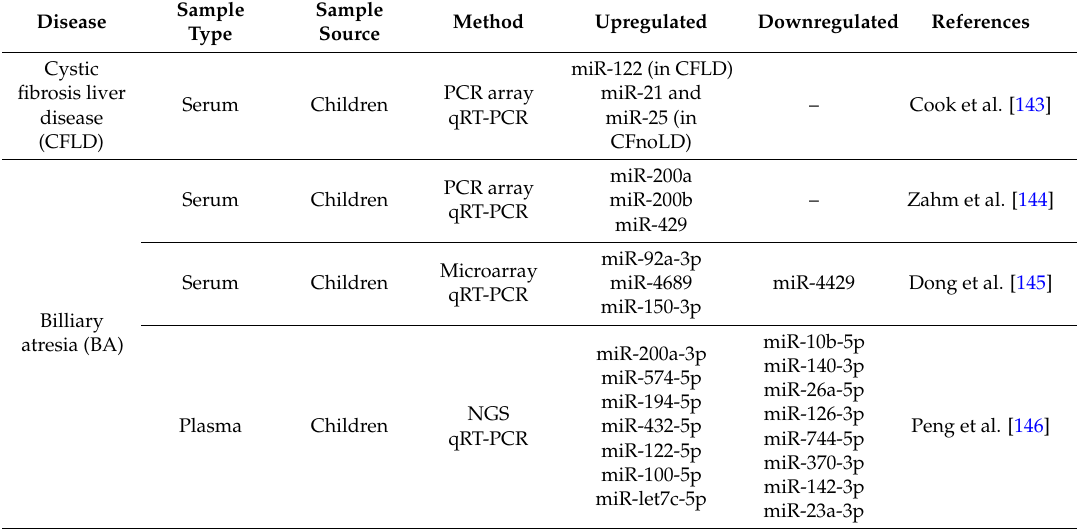
Table 3. Circulatory miRNAs differentially expressed in paediatric liver